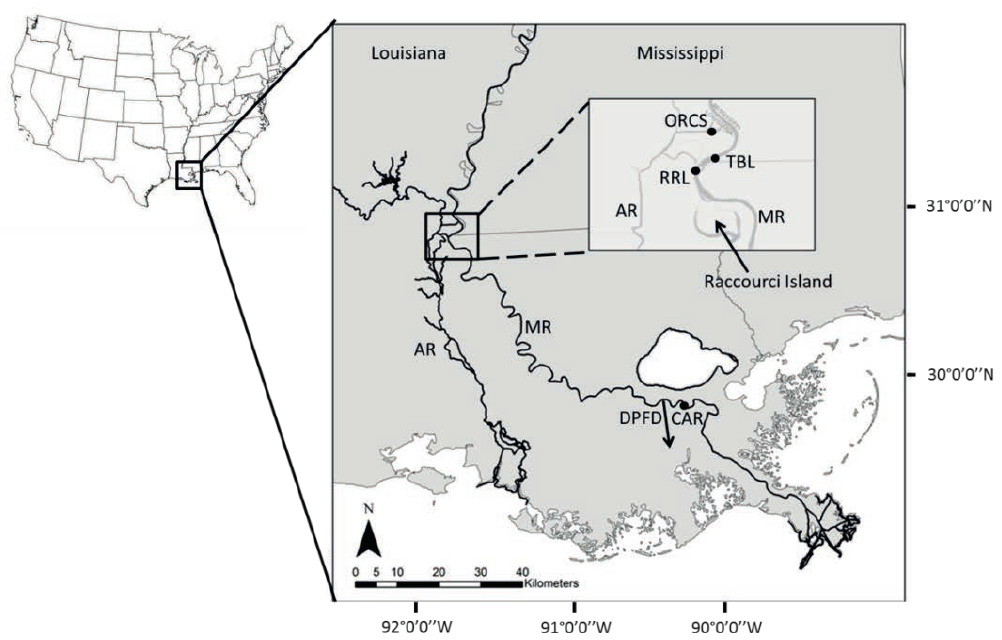
Fig. 1 The lower Mississippi River main channel (MR) and the Atchafalaya River distributary (AR). The Atchafalaya River distributary carries approximately 25% of the Mississippi River’s flow and the entire flow from the Red River after the river diversion at the Old River Control Structure